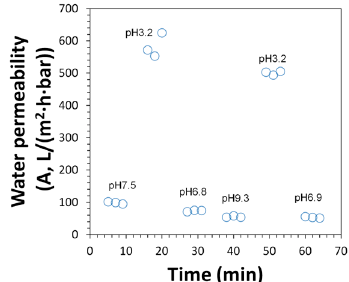
Figure 13. Water flux of N-PVDF-NaAc membrane functionalized by sodium acrylate (NaAc) polymerization at different pH. Membrane weight gain: 14.6%.